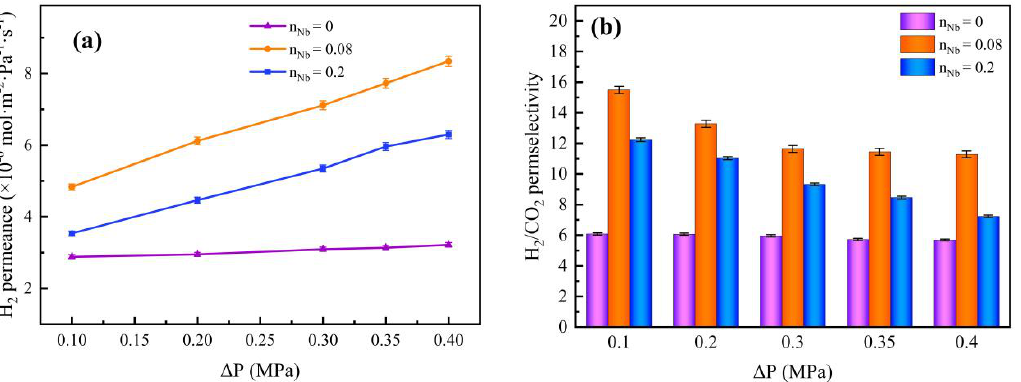
Figure 17. Effect of pressure difference on ( a ) H 2 permeance and ( b ) H 2 /CO 2 permselectivity of Nb/SiO 2 membranes with different n Nb at 200 °C.